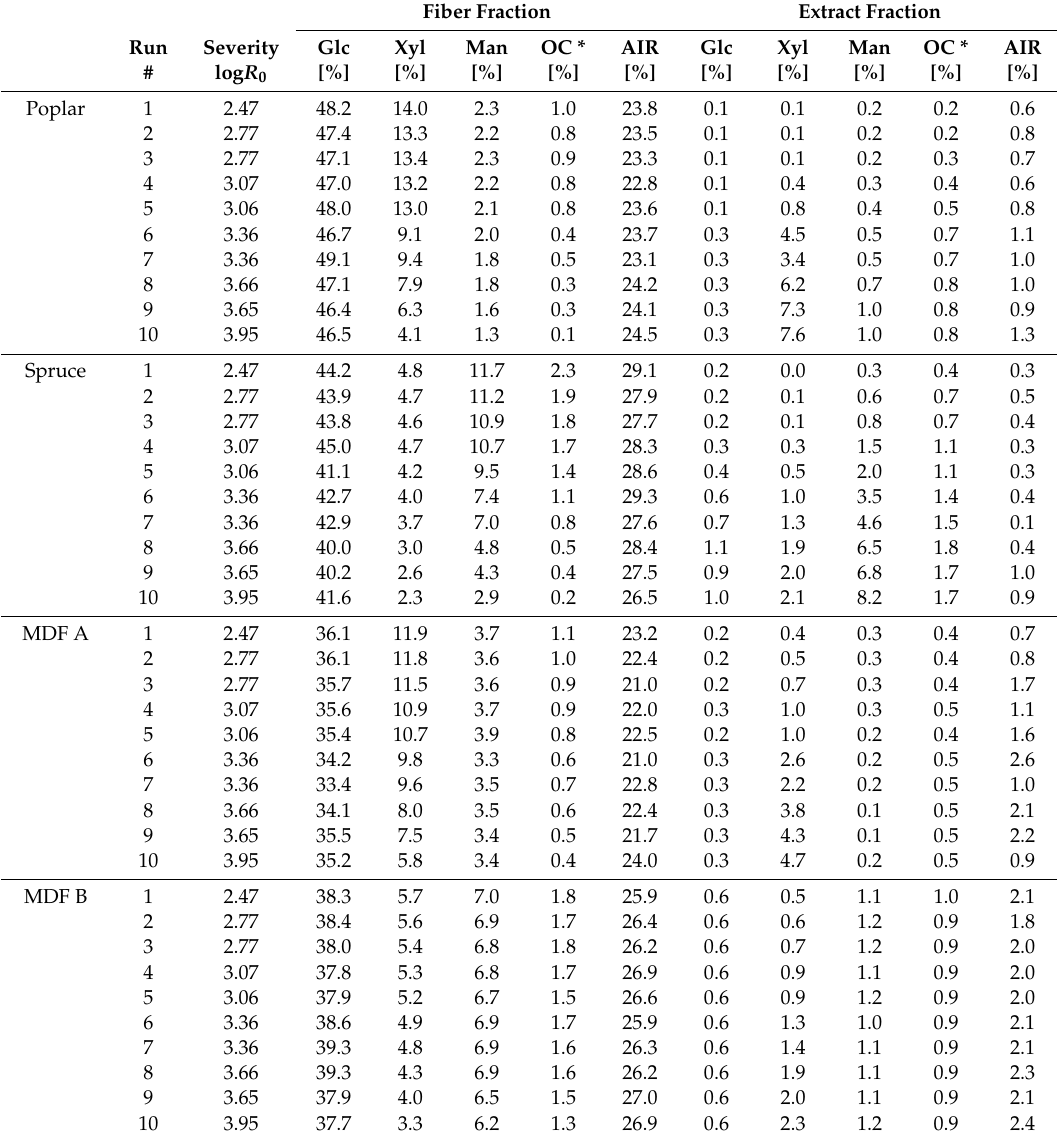
Table 3. Carbohydrates and lignin content in the fiber and extract fraction (in % based on raw material).